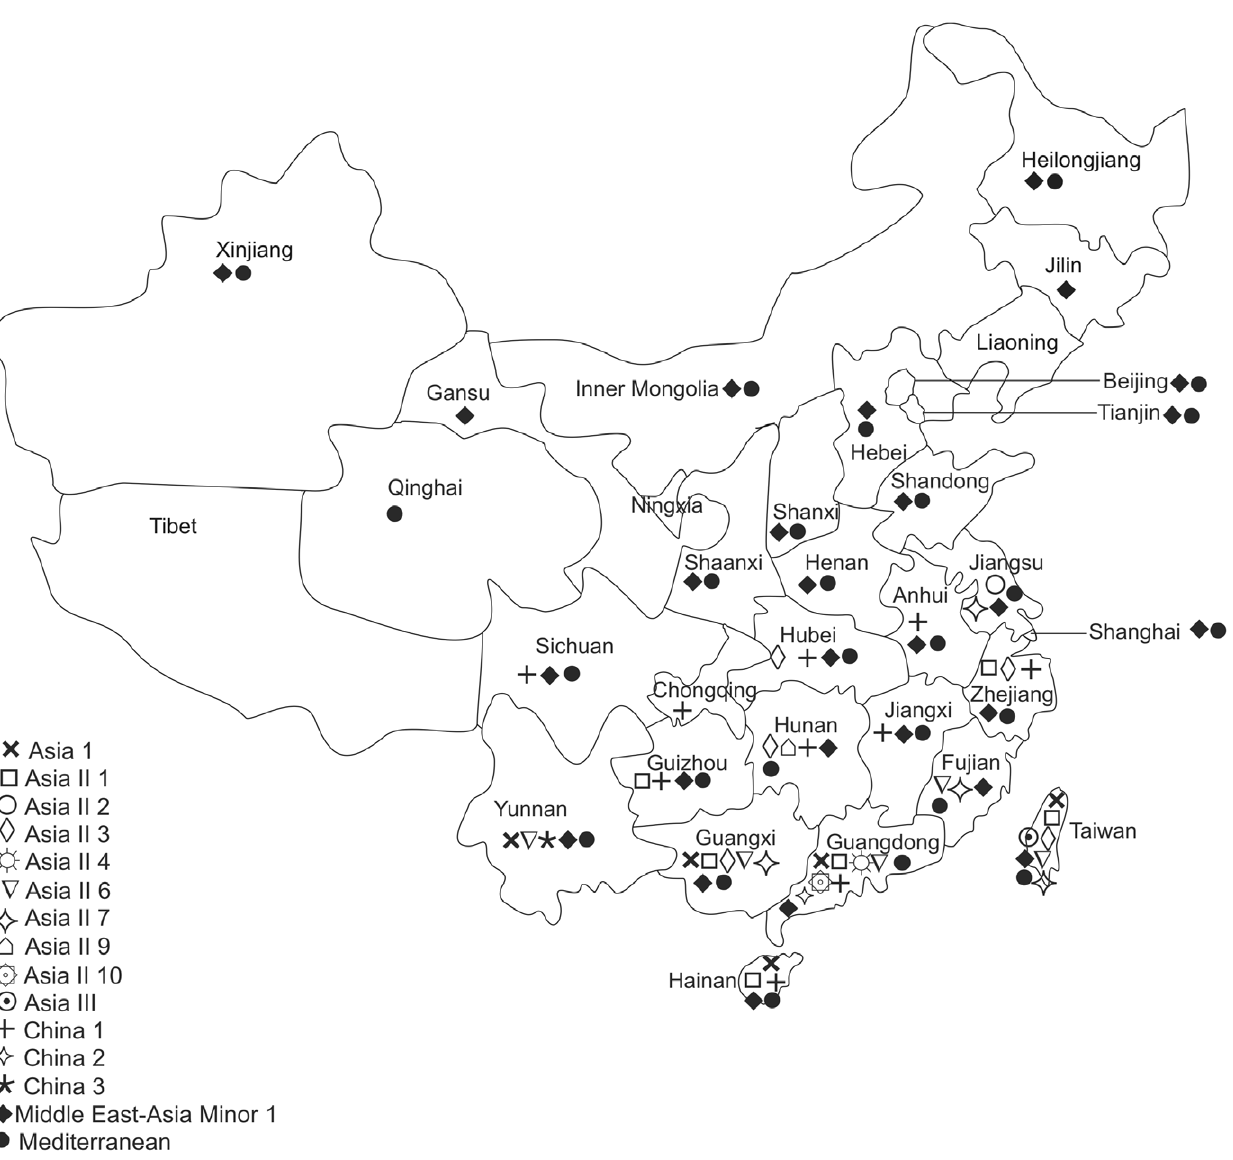
Figure 1. Distributions of the different species belonging to the B.tabaci species complex in China. Species records are either from the survey undertaken as part of this study or from records in GenBank (see Fig. 2 for accession details).